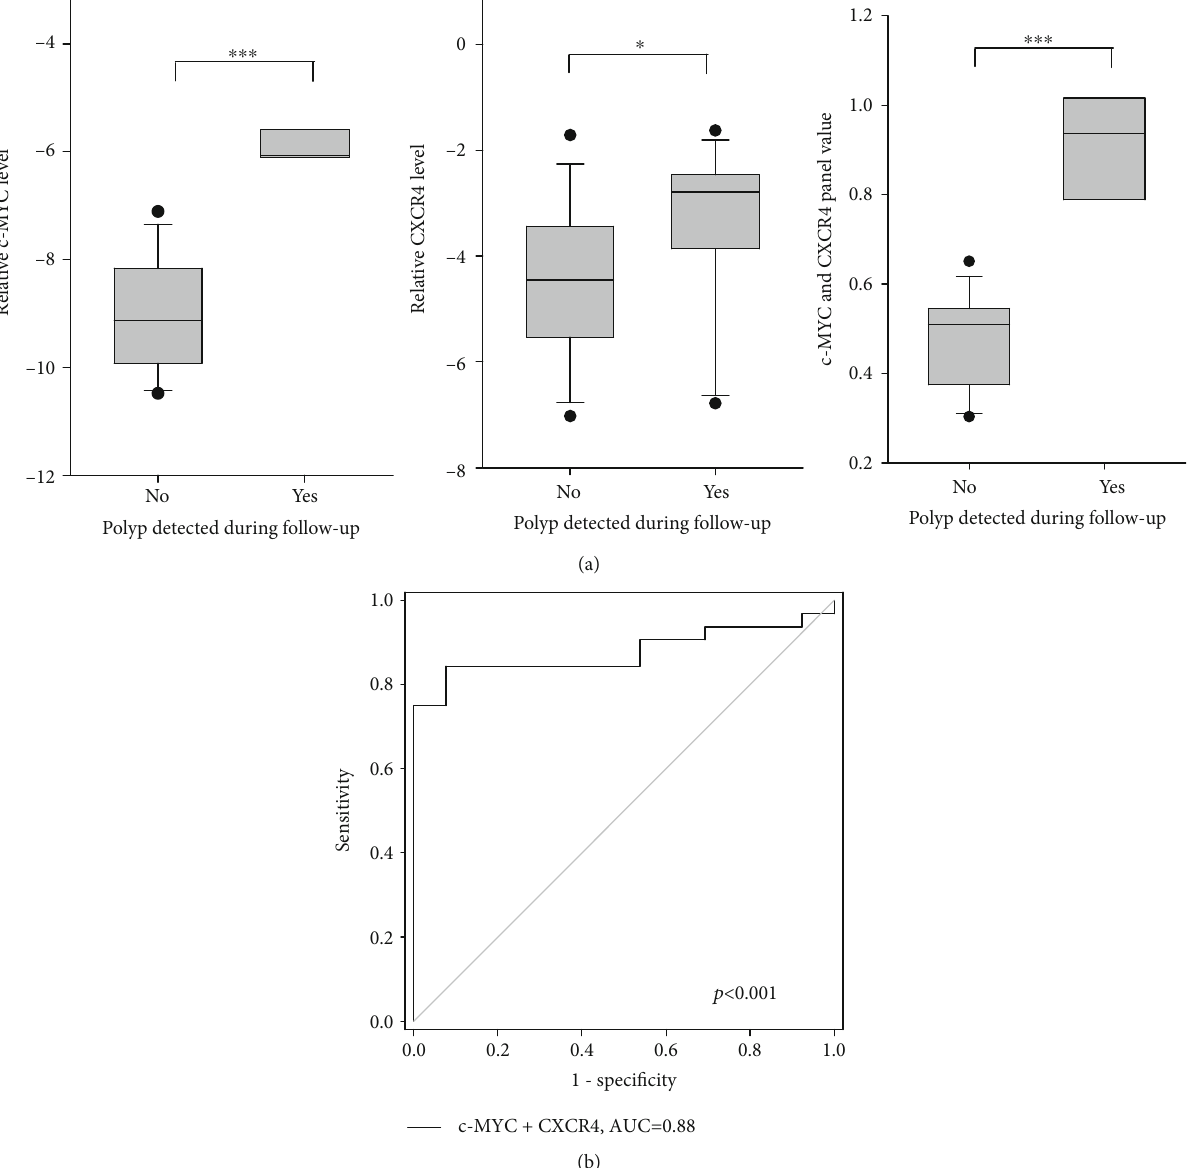
Figure 7: Prognostic signi fi cance of c-MYC and CXCR4 and their panel. (a) Comparison of level of c-MYC and CXCR4 and their panel in normal patients with or without polyp detected during follow-up. (b) ROC analyses of c-MYC and CXCR4 panel when patients with polyp detected during follow-up were included in the polyp and CRC